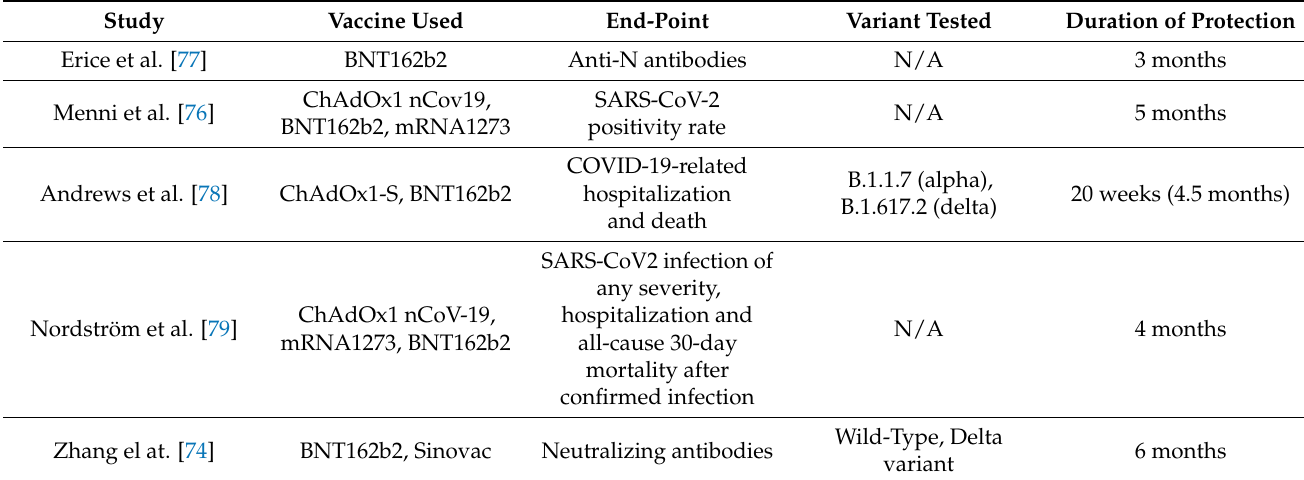
Table 2. Duration of protection induced by two doses of COVID-19